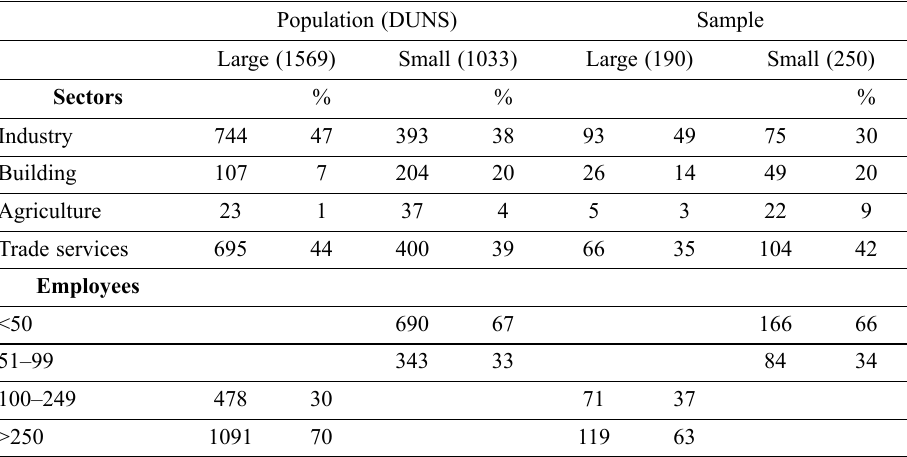
Table 1. Population and sample